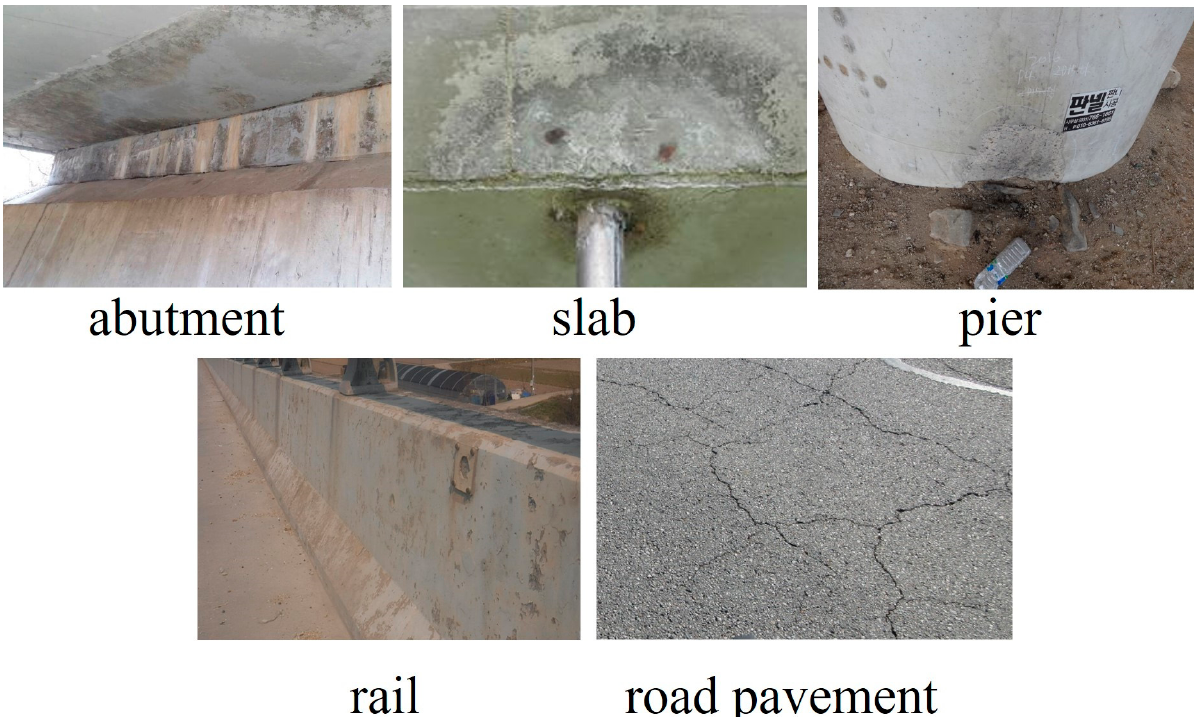
Figure 10. Type of bridge members.